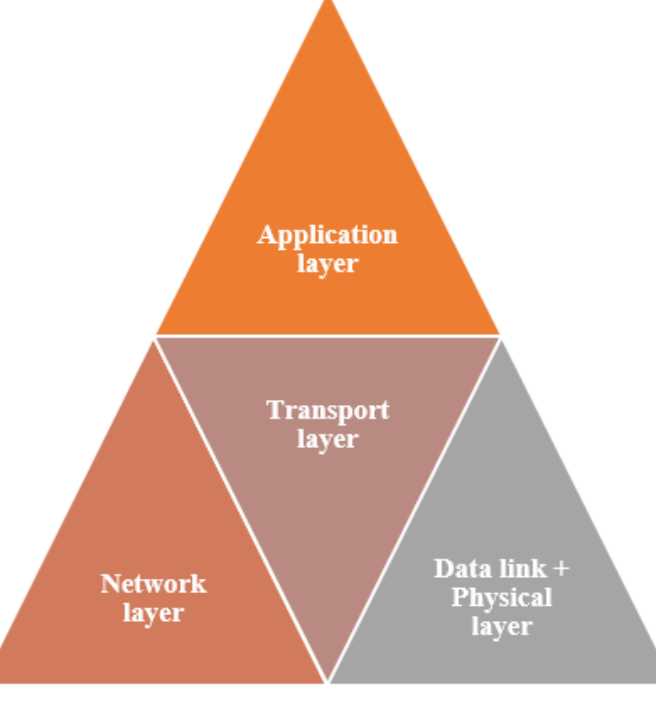
Figure 2. VANET’s